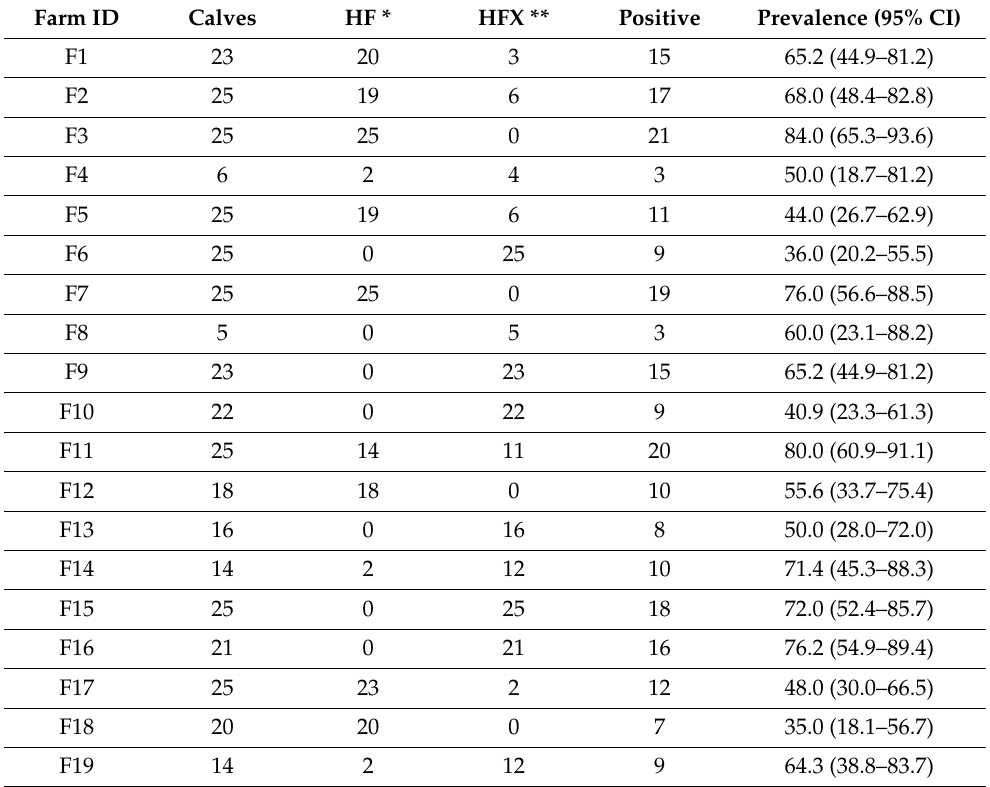
Table 2. Prevalence of Mycoplasma bovis exposures in calves in different farms in the southwest region of Western